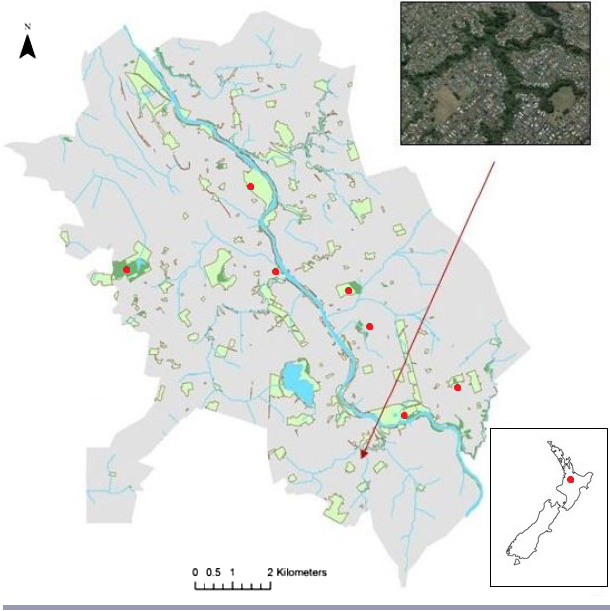
Fig. 1 . Map of Hamilton City showing the distribution of native forest (dark green), parks and golf courses (light green), and gully streams feeding into the Waikato River (blue). Top inset: Mangakotukututku Gully (Google Earth), bottom inset: location of Hamilton in New Zealand. Red dots mark the location of sites visited in this study. Map adapted from Clarkson et al. 2018, with